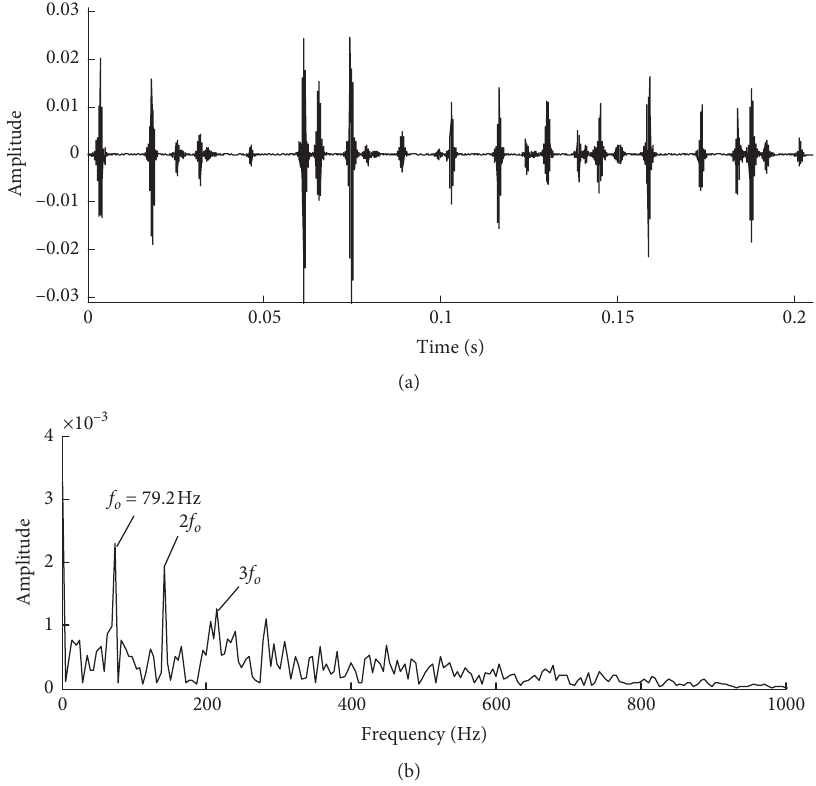
Figure 23: Fault signal and envelope spectrum of outer race after